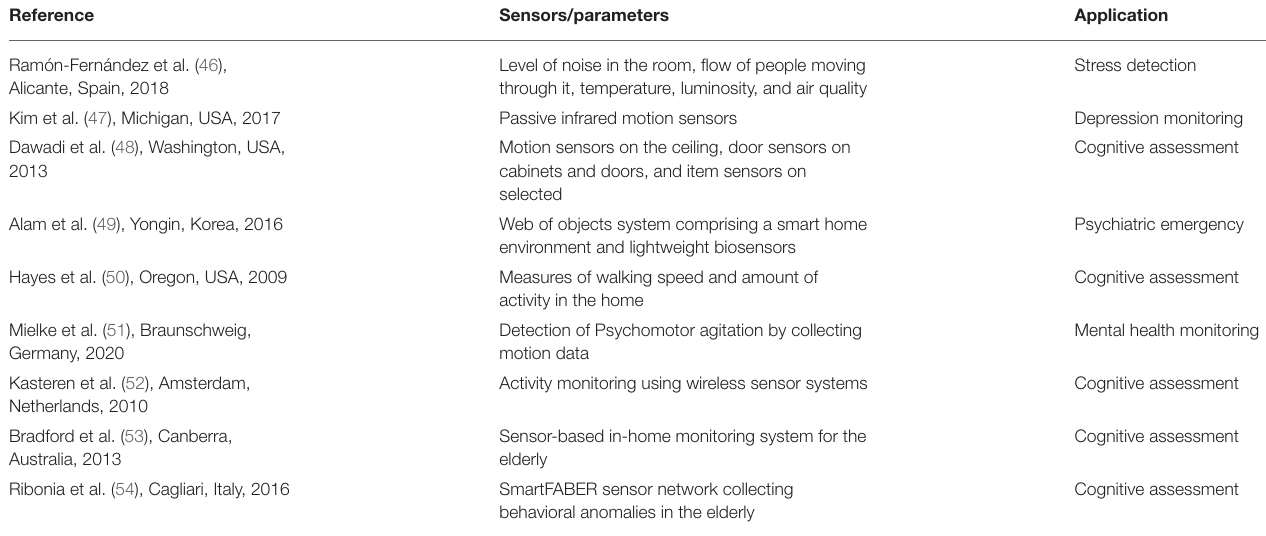
TABLE 3 | Ambient mental health monitoring research